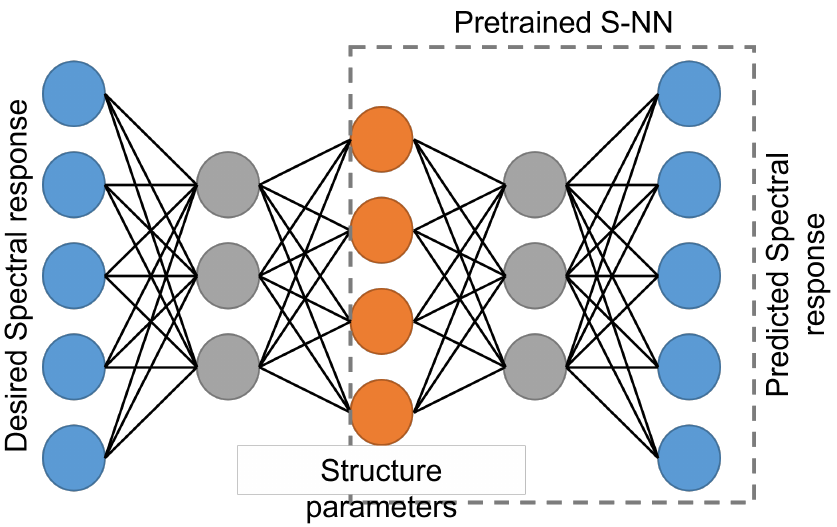
Figure 1. A simplified tandem network showing the pretrained SNN network as connected to the inverse network. The hidden layers are represented by the grey nodes, where, in practice, there would be multiple layers.